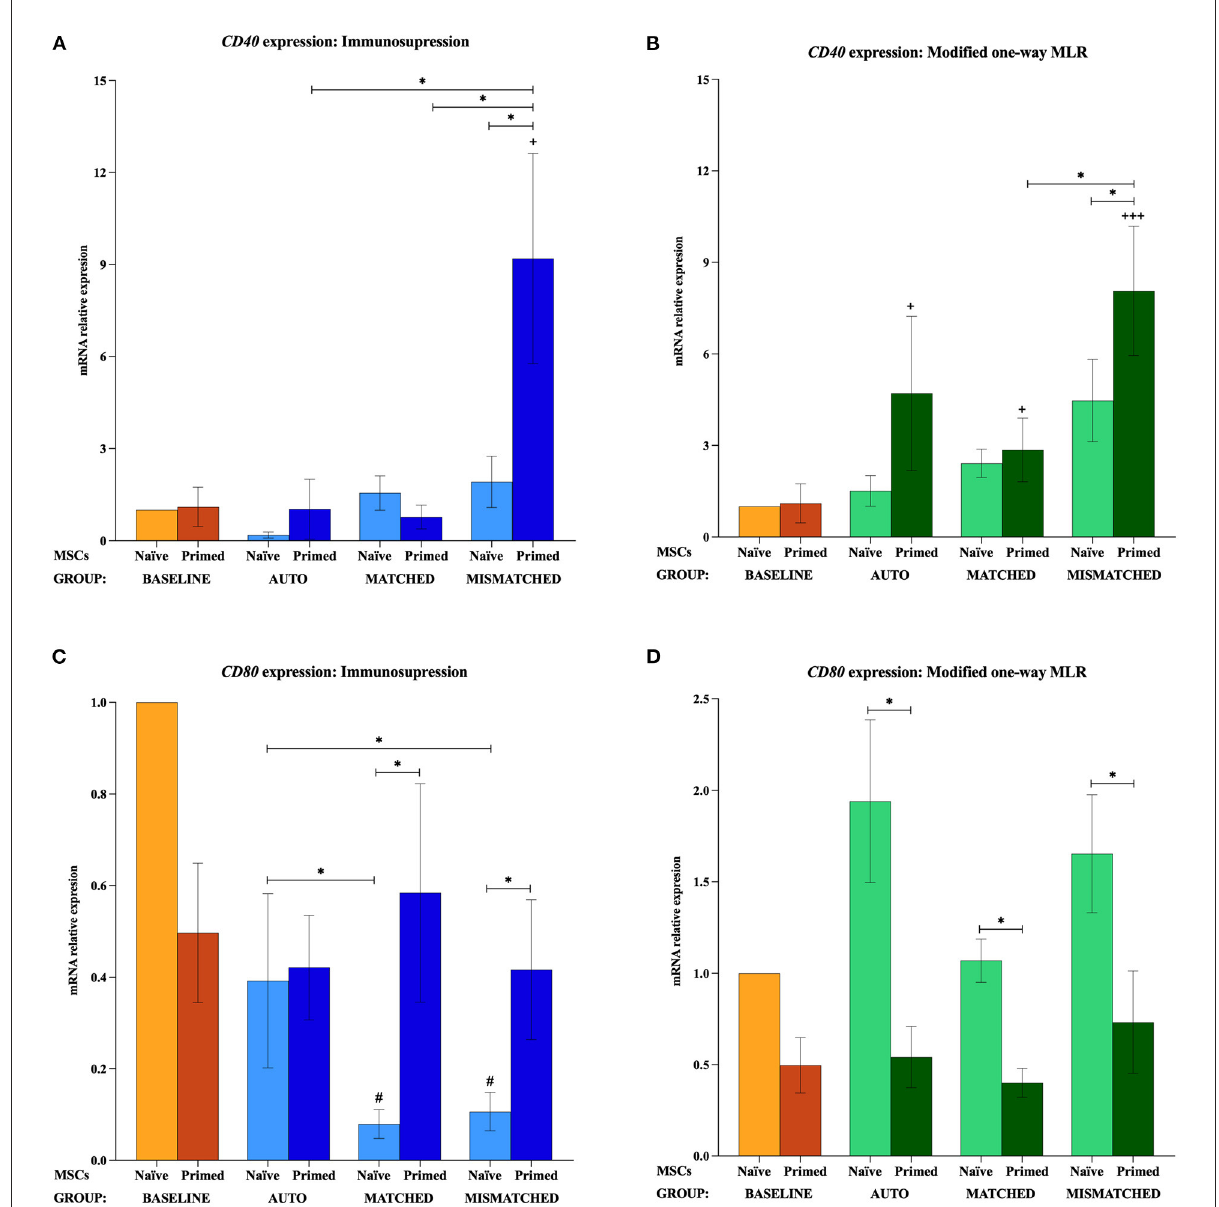
FIGURE6 Changes in costimulatory molecules CD40 and CD80 expression by equine mesenchymal stem cells (MSCs) in the different scenarios. (A) CD40 and (C) CD80 mRNA relative expression before (baseline; orange bars) and after equine MSC-naive (light blue bars) and MSC-primed (dark blue bars) were exposed in vitro to phytohemagglutinin (PHA)-activated peripheral blood lymphocytes (PBLs) (immunosuppression assays). (B) CD40 and (D) CD80 mRNA relative expression before (baseline; orange bars) and after MSC-naive (light green bars) and MSC-primed (dark green bars) were exposed in vitro to resting PBLs [modified one-way mixed lymphocyte reaction (MLR) assays]. Co-cultures of MSCs and PBLs were autologous ( n = 3) or allogeneic, matched ( n = 8), or mismatched ( n = 7) for the major histocompatibility complex. Changes in gene expression are represented as mean ± S.E.M of the relative mRNA expression, using baseline MSC-naive as reference sample (light orange bar, value 1). Significant differences in each condition compared with the baseline MSC-naive (light orange bar) are represented by hashes (#) above the corresponding bar ( # p < 0.05). Significant differences compared with the baseline MSC-primed (dark orange bar) are represented by a cross ( + ) above the corresponding bar ( + p < 0.05; +++ p < 0.001). Significant differences between experimental conditions are represented by a squared line with an asterisk ( * p <